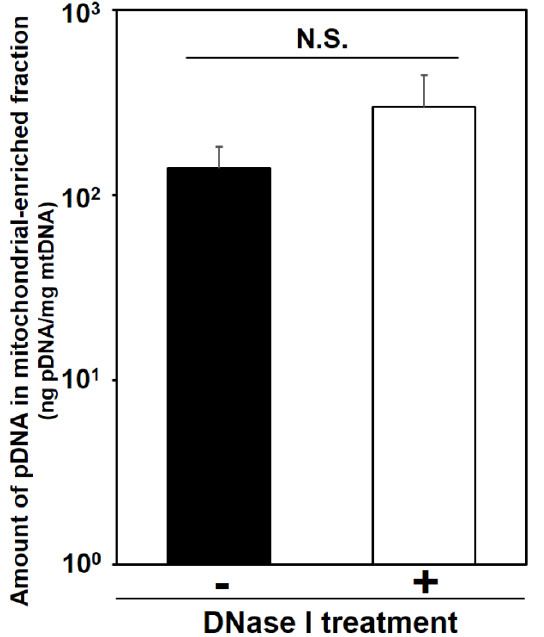
Figure 4. Detection of exogenous pDNA in the mitochondria-enriched fraction before and after DNase treatment. At 24 h after HLV injection of the condensed pDNA, the crural muscles were harvested, and the pDNA in mitochondria-enriched fraction was then measured using q-PCR, before and after treatment with DNase I. Bars indicate means ± S.D. ( n = 3). Statistical analysis was performed by a two-tailed unpaired Student’s t -test. N.S. indicates non-significant